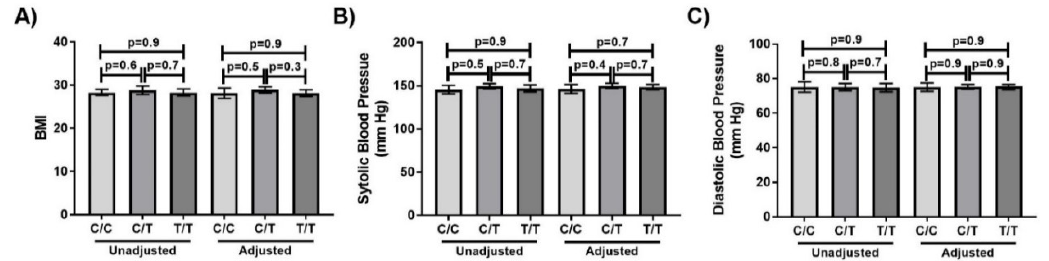
Figure 3. BMI, systolic blood pressure and diastolic blood pressure do not vary by TRPV1-rs8065080 genotype in the elderly. ( A ) BMI ( B ) Systolic blood pressure ( C ) Diastolic blood pressure. Error bars mark 95% confidence intervals. Unadjusted present mean values with no adjustments. Adjusted present Least-squares means with adjustments for age, smoking status, education and income.